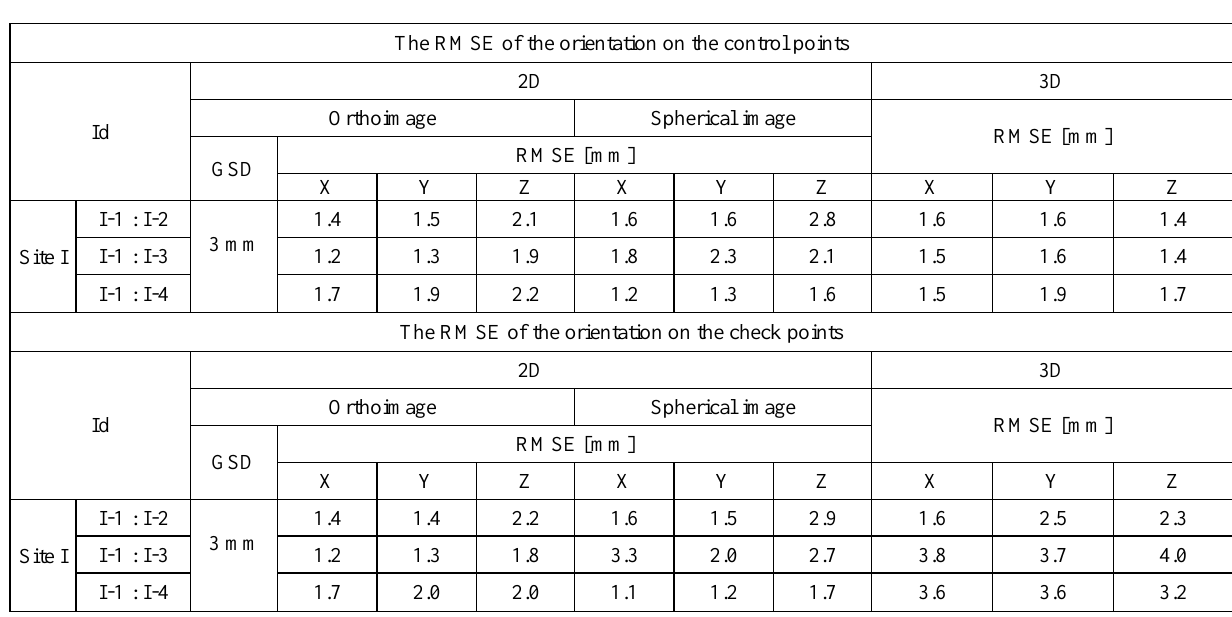
Figure 4. The distribution of the tie points for the worst case (Test site II): A) 2D detector and orthoimage, B) 2D detector and spherical image, C) 3D detector and point cloud